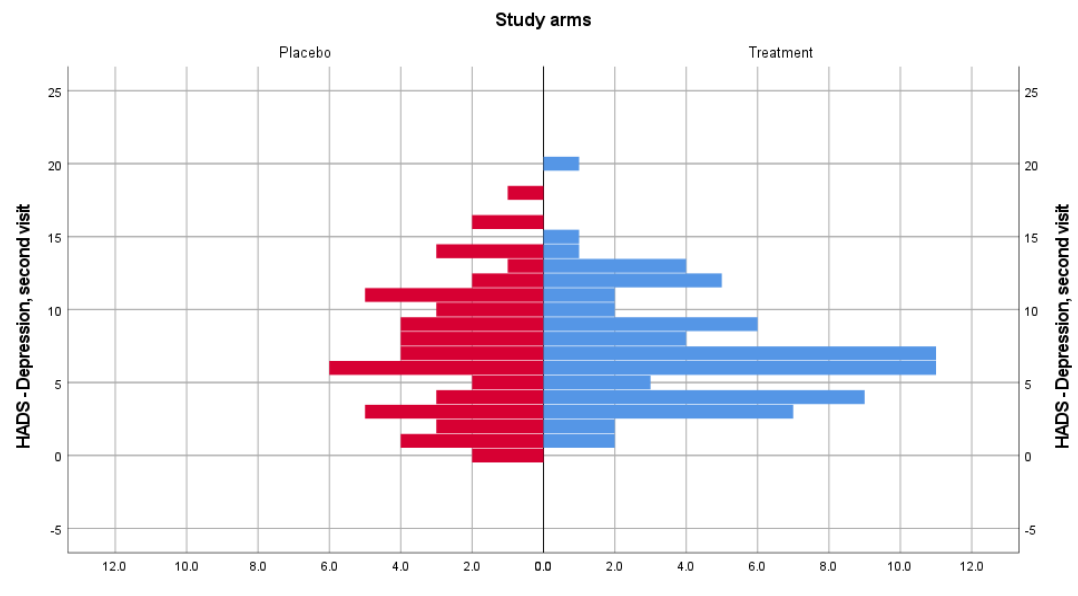
Figure 3. HADS-Depression score distribution for the treatment and placebo groups for the Figure 3. HADS − Depression score distribution for the treatment and placebo groups for the second second visit.